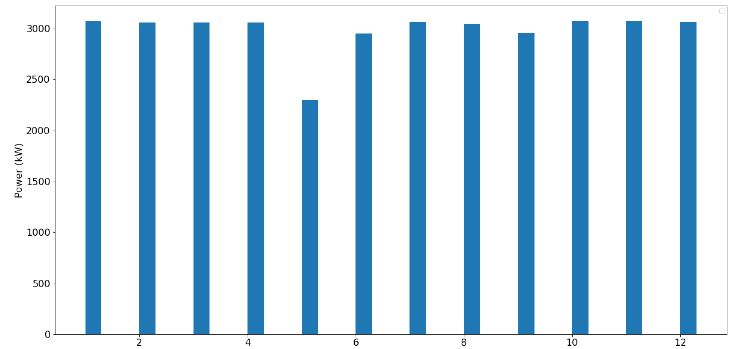
Figure 10. Power recorded according to each